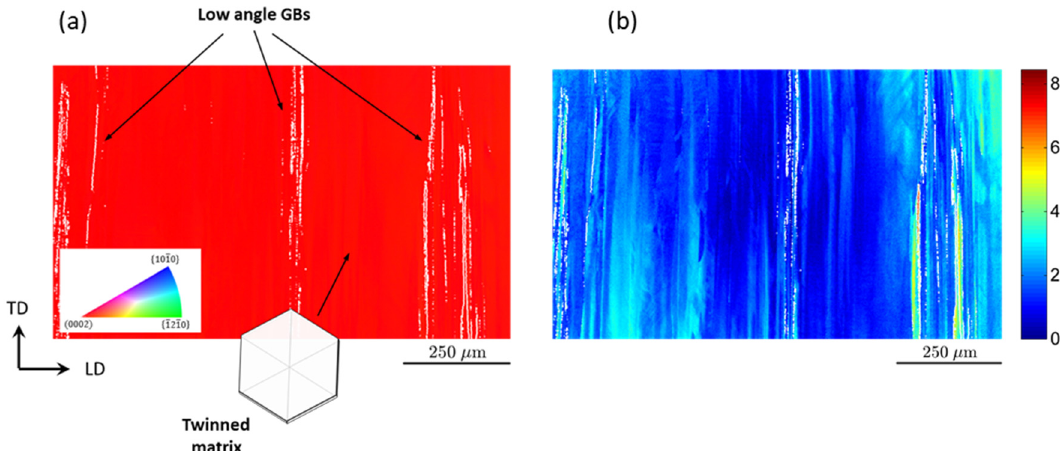
Figure 13. ( a ) Orientation map of a specimen of orientation D from Figure 12b ( ε t = − 10.5%). White lines represent low angle grain boundaries (GBs). ( b ) Grain Reference Orientation Deviation in [°] for the map in ( a ).